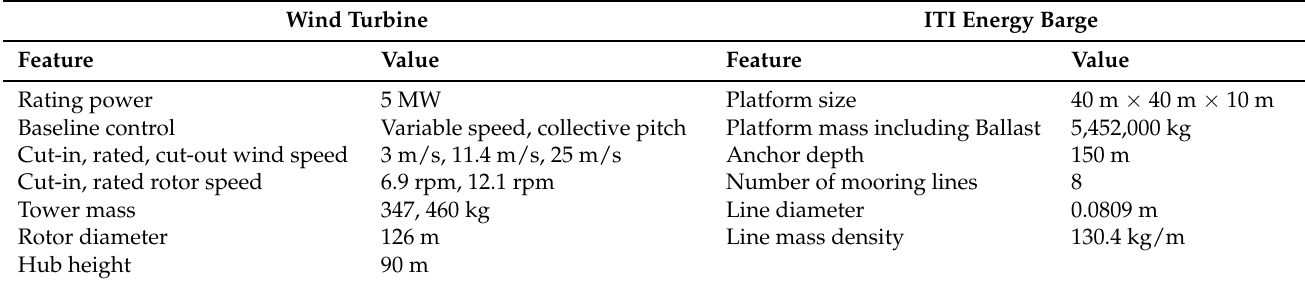
Figure 1. Schematic of a floating offshore wind turbine on an ITI Energy barge platform. Table 1. Parameters of the NREL 5 MW wind turbine and the ITI barge platform.